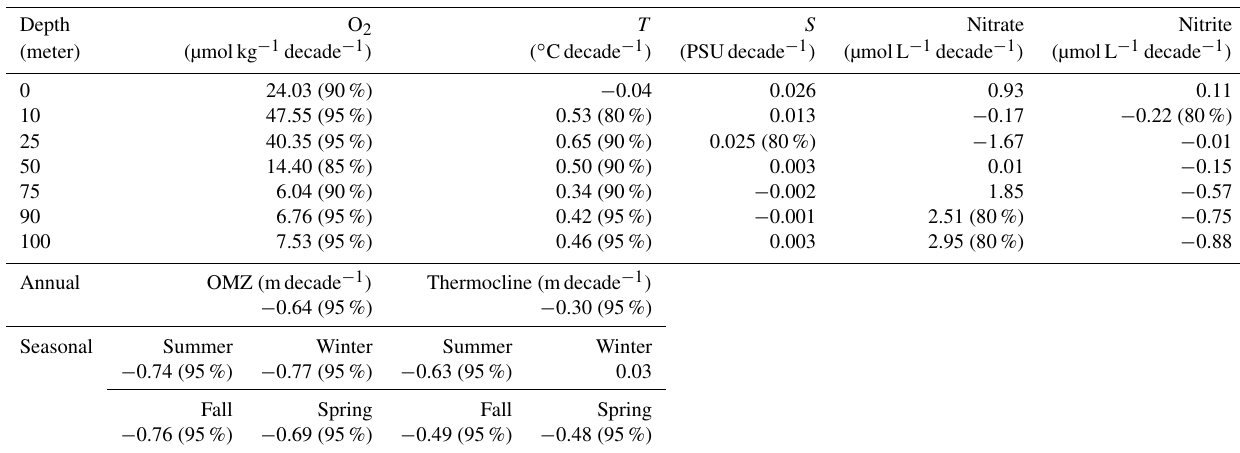
Table 2. Slope of the linear fit for oxygen, temperature, salinity, nitrate and nitrite as a function of depth over the period 1999–2011. The slope for thermocline and oxycline depths are also provided as a function of season. The confidence level estimated based on a Student’s t test is indicated in parenthesis when larger than